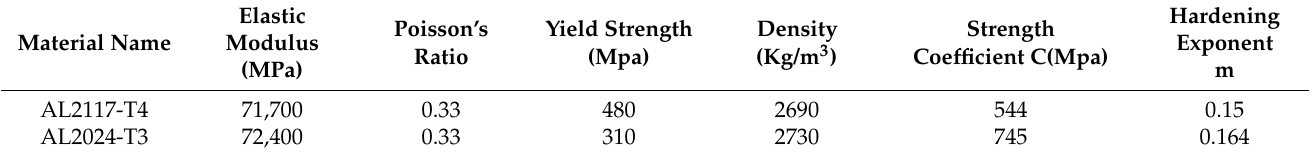
Table 1. Material parameters of connectors.